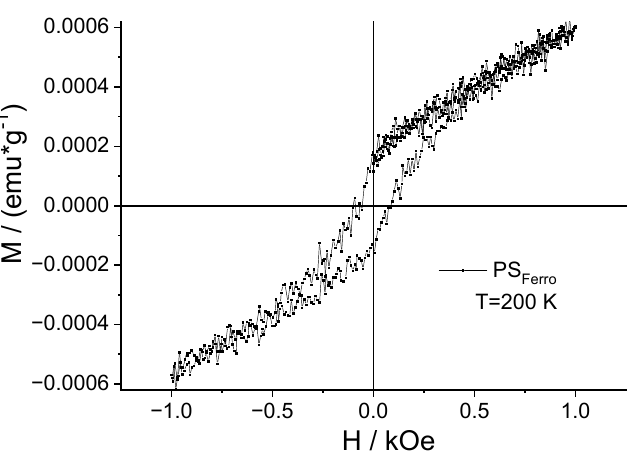
Figure 8. Magnetic field dependence of the specific magnetic moment for the PS Ferro at T = 200 K. This dependence is typical of the entire temperature range under study (5–300 K).